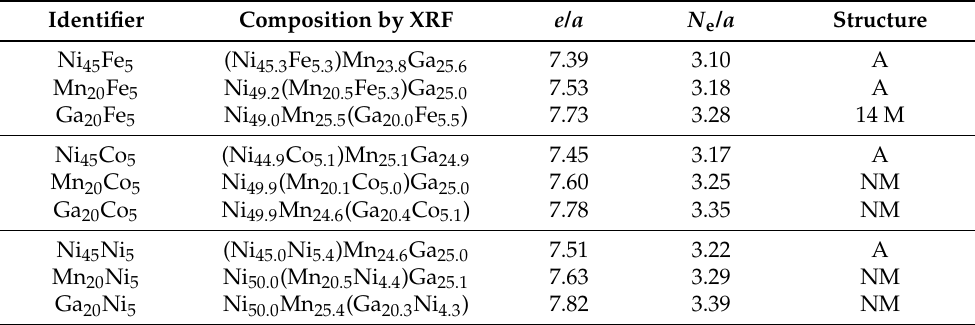
Table 1. Alloys with composition (atomic percent) given by XRF and their markings by unambiguous abbreviation; e/a stands for number of valence electrons per atom, and N e / a counts non-bonding electrons per atom (evaluated from measured composition); structure is determined at room temper- ature, where A, NM and 14 M represent cubic austenite, tetragonal non-modulated and 14-layered monoclinic structures,